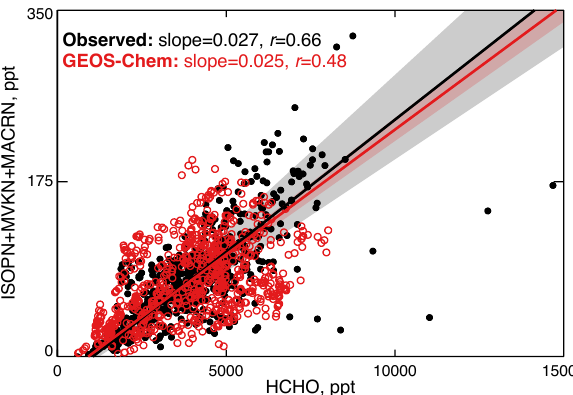
Figure 9. Observed (black) and simulated (red) correlations be- tween HCHO and the sum of major isoprene nitrates produced via daytime isoprene oxidation (ISOPN + MVKN + MACRN) in South- east US surface air ( < 1km) during SEAC 4 RS. Thick solid lines indicate the best fit as calculated from a reduced major axis regres- sion, and shaded areas show the 95% confidence interval on the regression slope as determined by bootstrap resampling. The regres- sion slopes and correlation coefficients are given